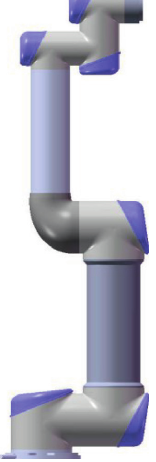
Figure 4: UR5 robot